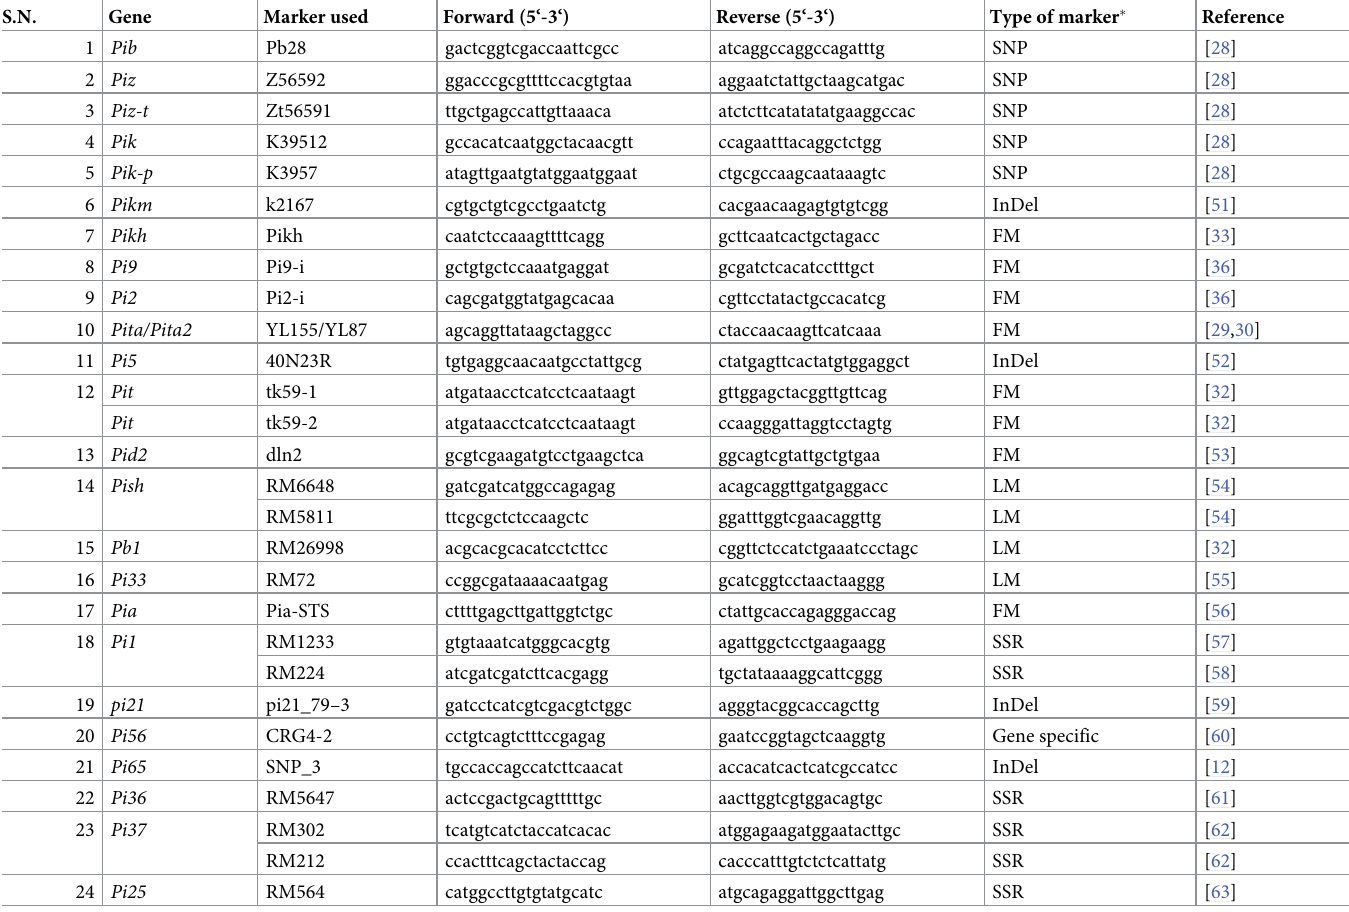
Table 1. List of markers used for blast resistance and their details.